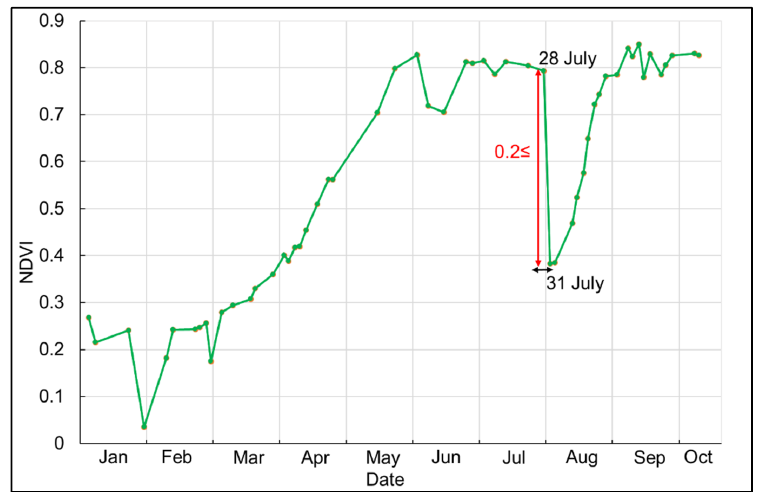
Figure 7. NDVI time series example showing the drop in reflectance due to mowing and the detected time interval.